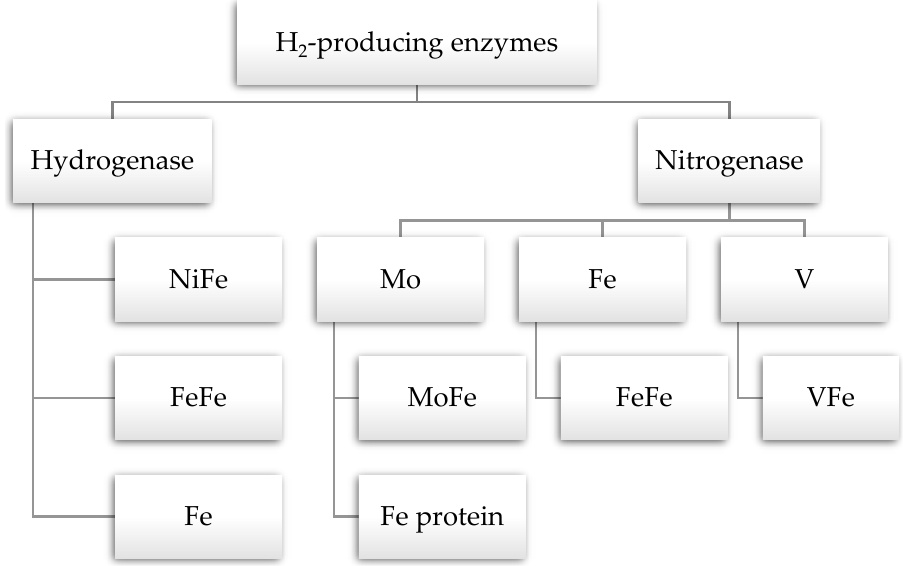
Figure 6. Enzymes involved in hydrogen production.